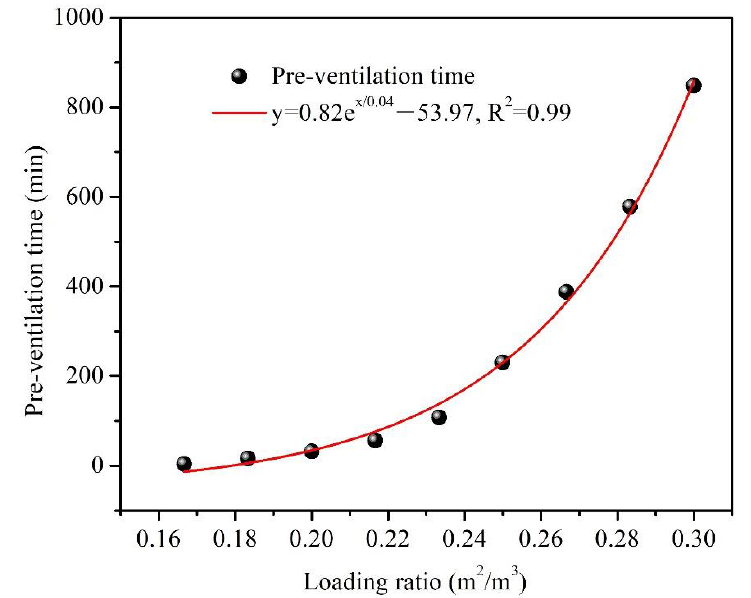
Figure 12. The relationship between the pre-ventilation time and the loading ratio.